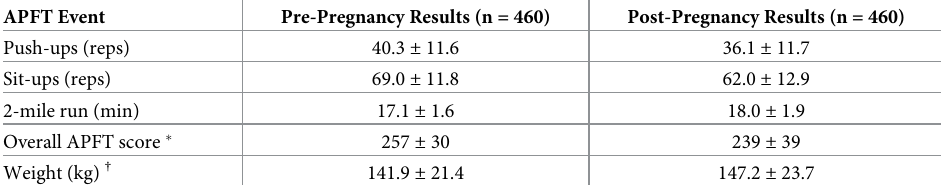
APFT, Army Physical Fitness Test. Data are mean ± SD. All post-pregnancy APFT events were significantly different vs pre-pregnancy (p < .001).